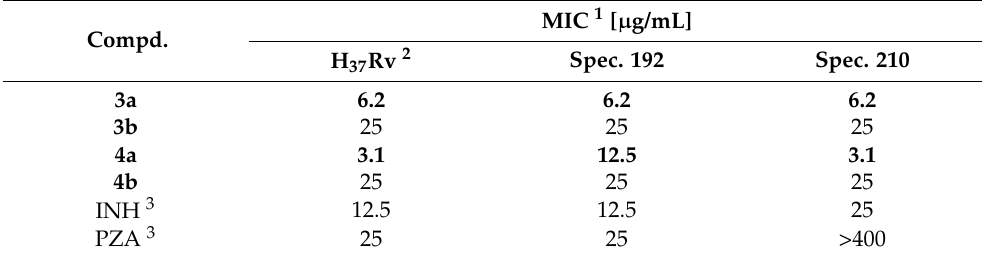
Table 2. Tuberculostatic activity of tested compounds 1,2,3 .